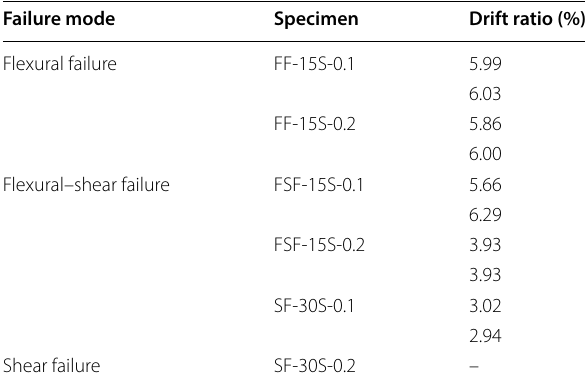
, n , n , n , n , and n Table 8 Dividing points between the damage levels IV s sp s, max f pf f,max. and